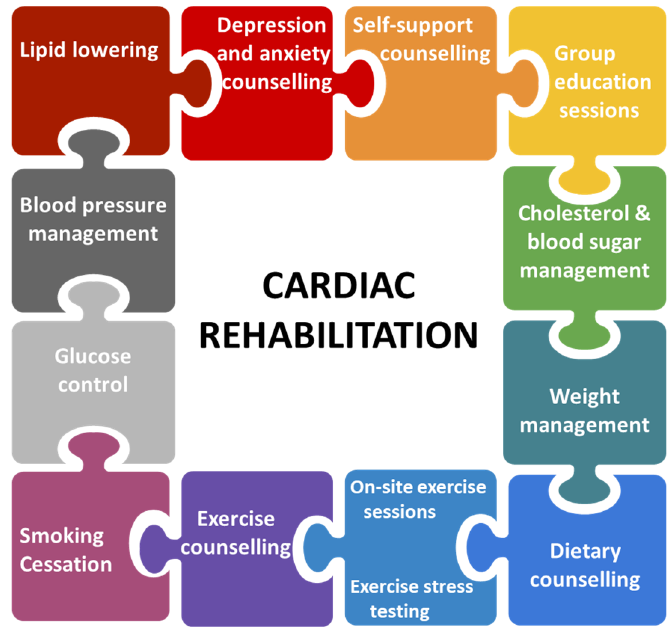
Figure 1. Components of cardiac